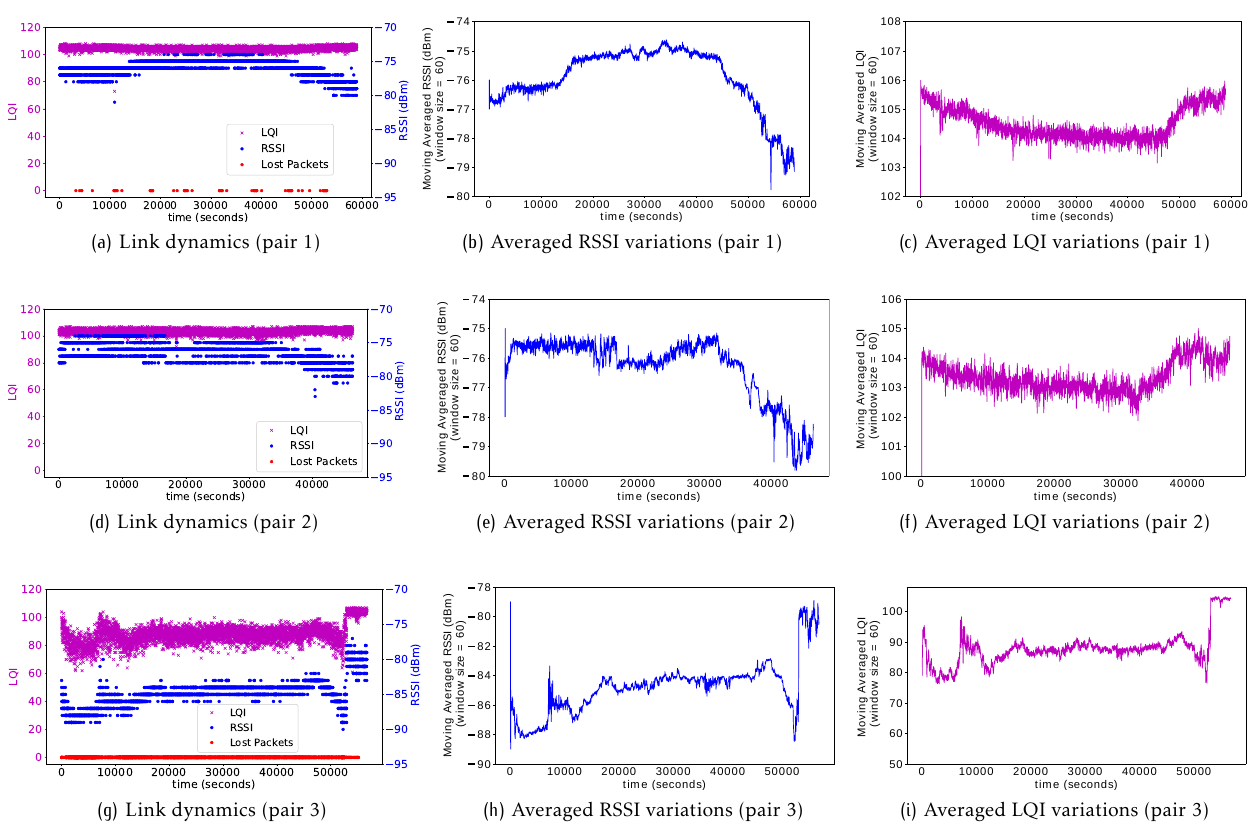
Figure 14. Wireless link dynamics in agricultural farm Table 2. Analysis of consecutive graphs Parameter Graph1 Graph2 Graph3 Graph4